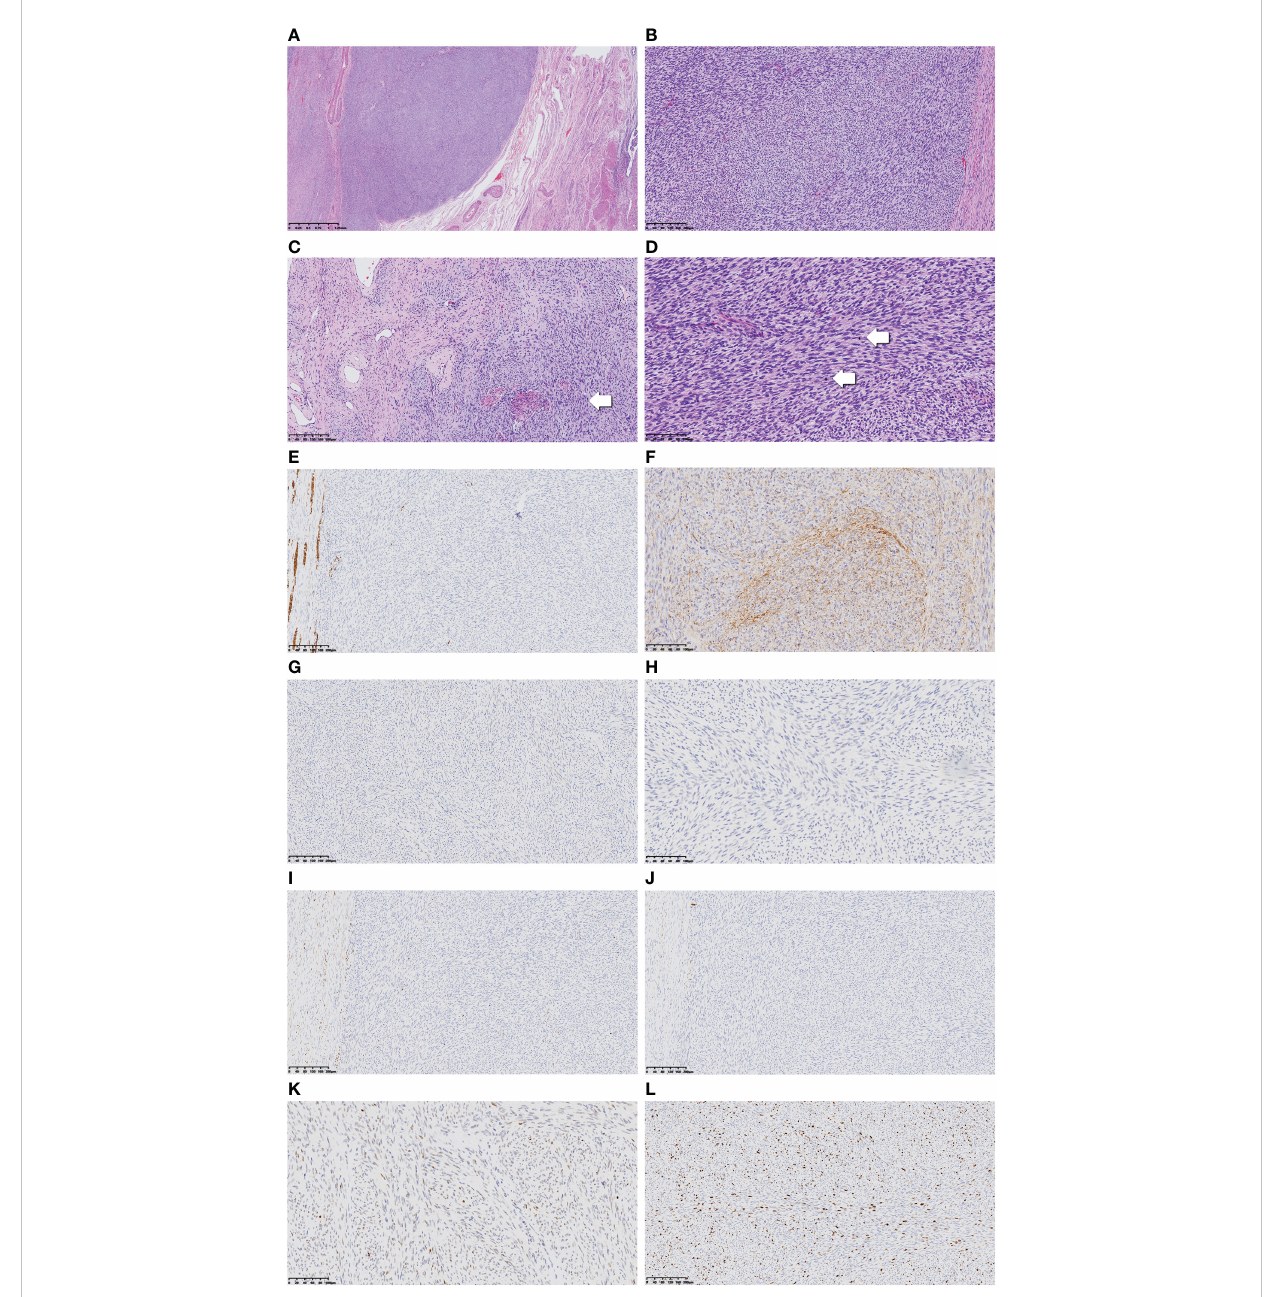
FIGURE 1 Low-power view of the tumor revealed relatively clear boundary ( A , ×40). Tumor cells were arranged in a more prominent storiform or herringbone pattern in the cellular view ( B , ×100), whereas in the cell-sparse area, more dilated small blood vessels can be seen. Normal cervical fi bromuscular tissue not invaded by the tumor as pointed by the arrow ( C , ×100). Tumor nuclei in oval to spindle shape are shown in high-power view, and the cytoplasm appears sparse and eosinophilic. The nuclear heteromorphism appears mild to moderate, while mitoses are numerous and obvious (arrow) ( D , ×200). Immunohistochemical results including desmin, CD34, TRK, S100, ER, PR, and P53 are displayed ( E – K , ×200). The Ki-67 proliferation index was high ( L ,